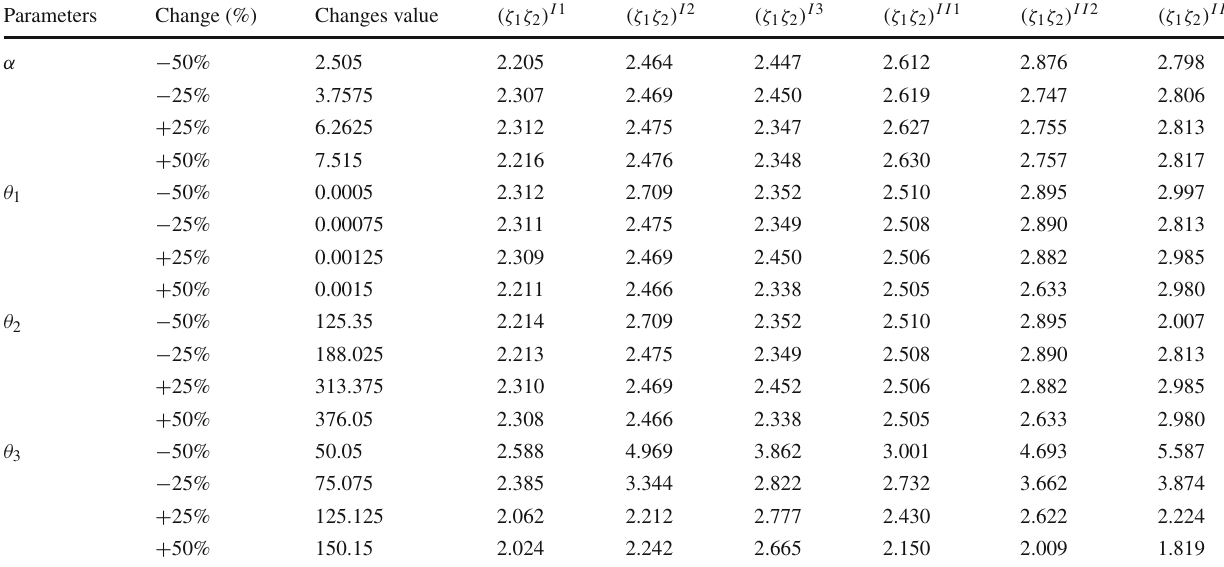
Table 8 Parameters changes value versus joint supply chain mark-up in different cases Parameters